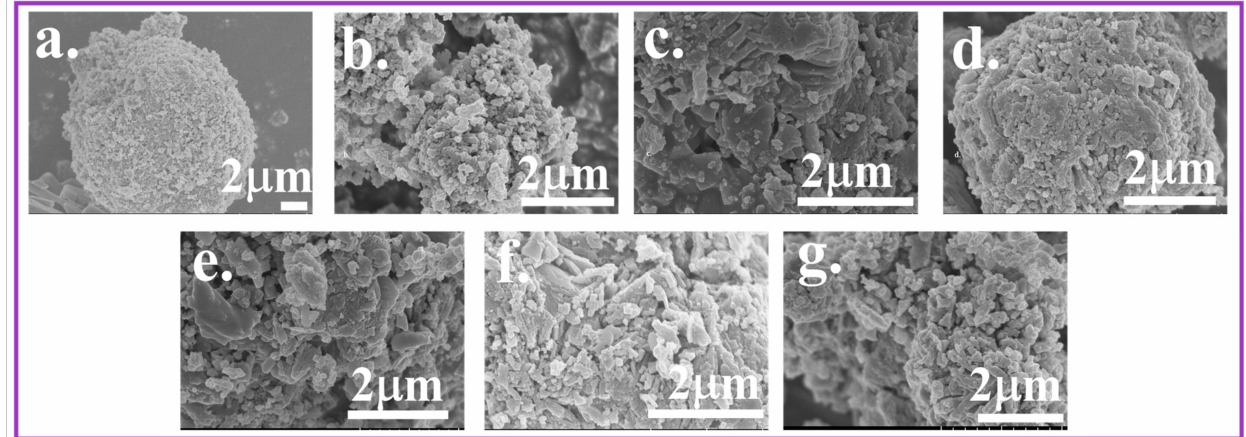
Figure 10. SEM imaging was obtained to observe the structural morphology of unpromoted catalyst (Blank-VPO) ( a ), and promoted catalysts prepared from DES-Nb ( b ), DES-Mo ( c ), DES-Zr ( d ), DES-Zr-Mo ( e ), DES-Zr-Nb ( f ), DES-Zr-Mo-Nb ( g